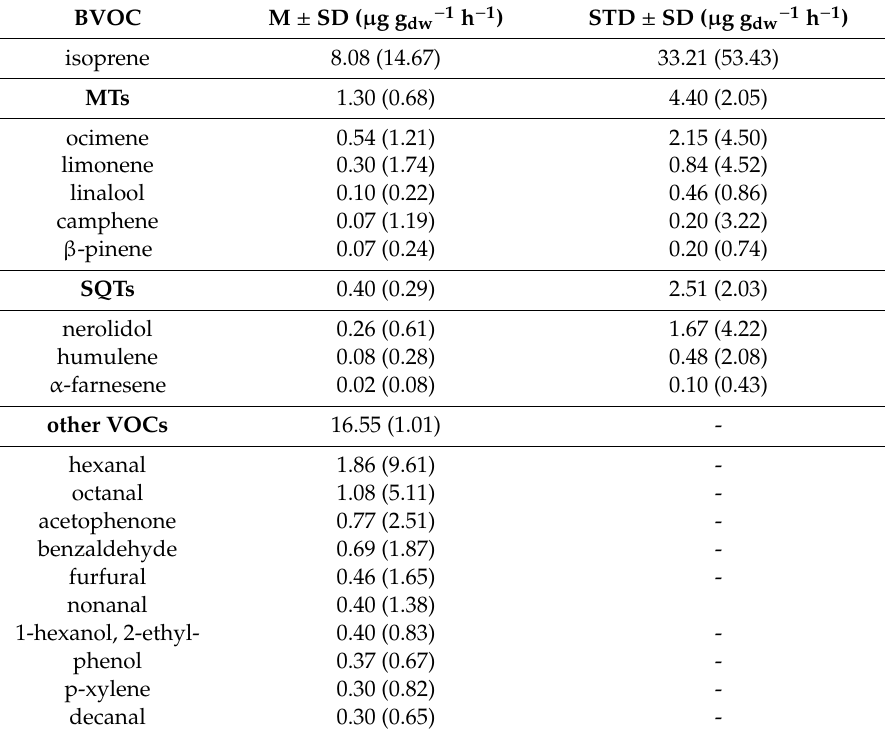
Table 4. The measured (M, µ g g dw − 1 h − 1 ) and standardized emissions (STD, µ g g dw − 1 h − 1 , n = 299) of the BVOC groups and some of the most abundant identified compounds in each group. The numbers in the parentheses are standard deviations (SD, µ g g dw − 1 h − 1 ). No standardization has been done on other VOCs ( −